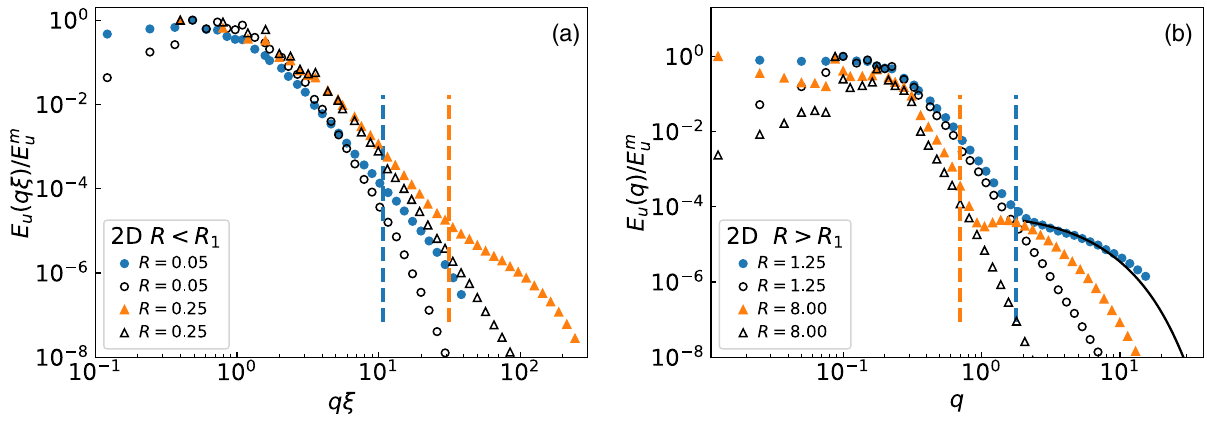
FIG. 7. Kinetic energy spectrum E u ð q Þ (filled symbols) for different values of R for 2D active suspension [runs SPP4, SPP9, and SPP10] for (a) R < R 1 and (b) R > R 1 . Similar to the order parameter spectrum, we observe power-law behavior for 1 < q ξ < q σ ξ , where q σ ≡ 2 π = l σ . For small q , we find a good agreement between the energy spectrum and the prediction E u ð q Þ ∼ ½ E p ð q Þ(cid:2) 2 (unfilled symbols). For R > R 1 and large q ( q > q σ ), the energy spectrum shows an exponential decay E u ð q Þ ∼ exp ð − 0 . 31 q Þ (black line). For different values of R , dashed vertical lines (with the same color as the markers) are drawn at q ¼ q σ